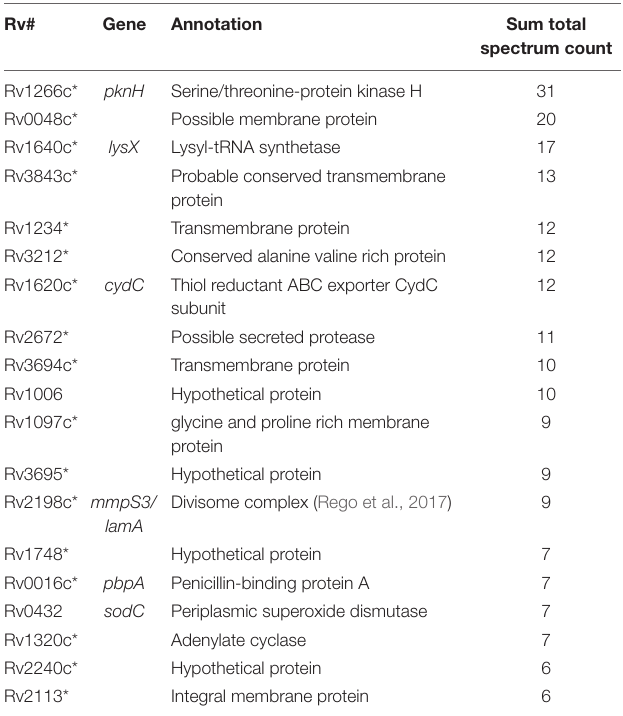
TABLE 1 | Identification of protein interaction partners of Rv0954 in Mtb by mass